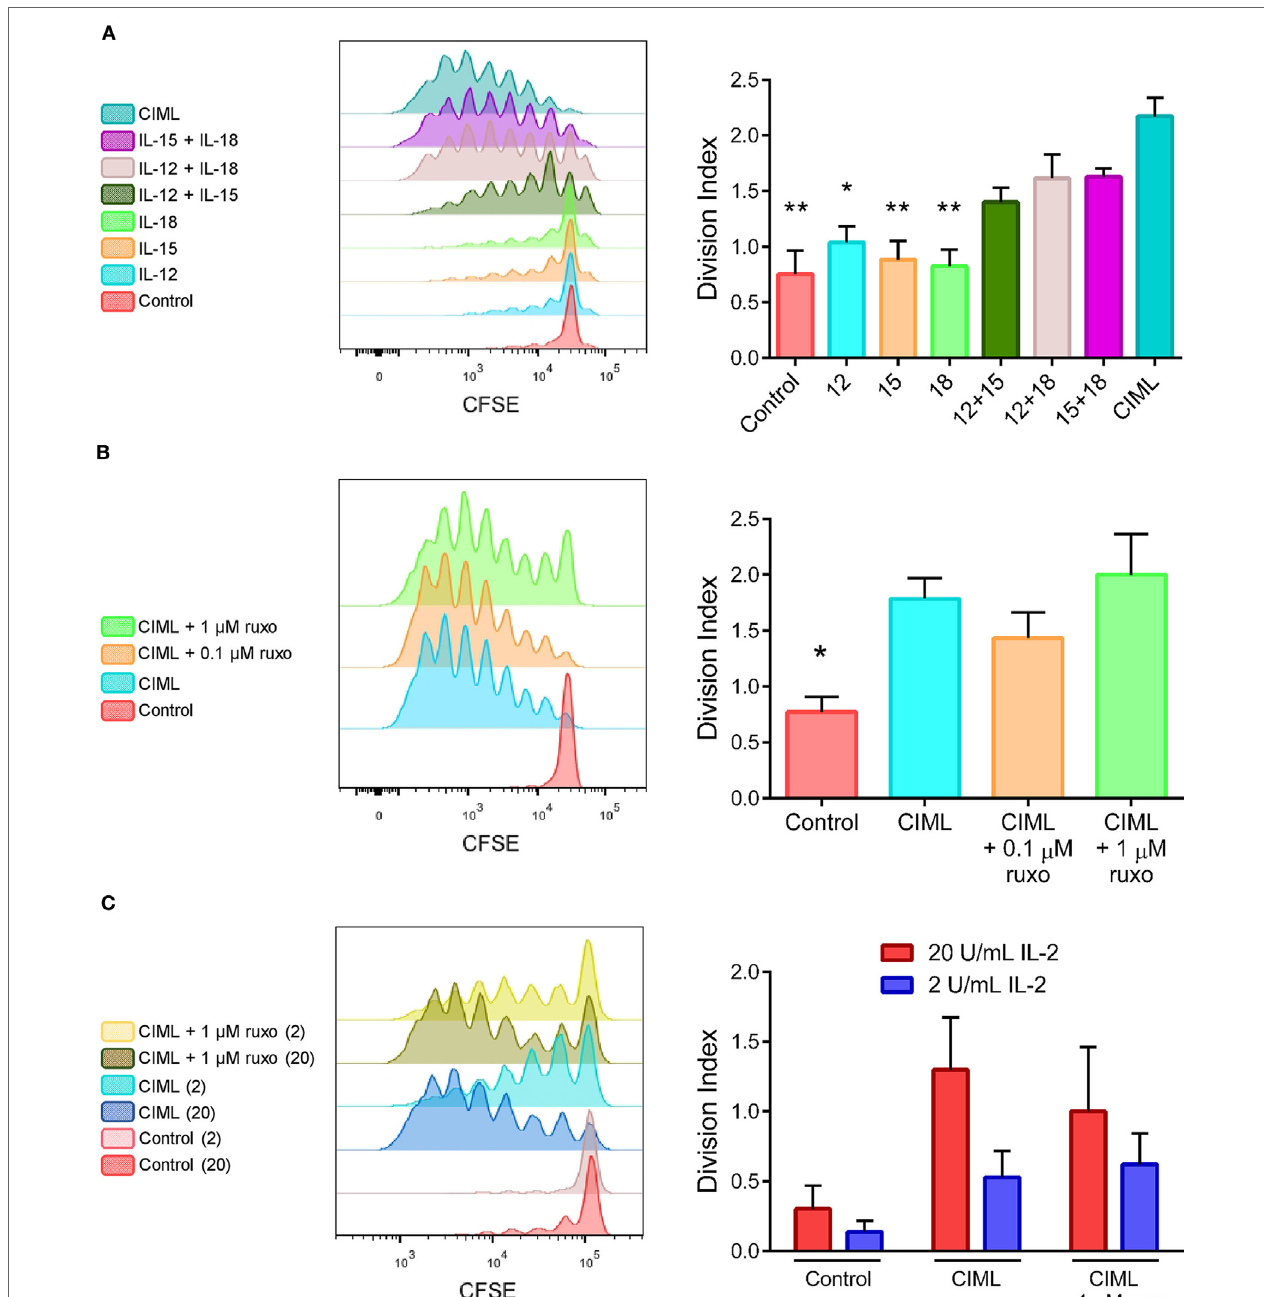
FigUre 5 | IL-2-induced proliferation of cytokine preactivated natural killer (NK) cells at the end of the expansion phase of 4 days. (a) Histograms of a representative experiment (left) and bar graphs showing the division index (DI) (right) of control non-preactivated and cytokine preactivated NK cells ( n = 6). (B) A representative experiment (left) and bar graphs showing the DI (right) of control non-preactivated and cytokine-induced memory-like (CIML) NK cells, and CIML NK cells preactivated in the presence 0.1 and 1 µM ruxolitinib ( n = 5). (c) A representative experiment (left) and bar graphs showing the DI (right) of control non-preactivated and CIML NK cells, preactivated in the presence and absence of 1 µM ruxolitinib, exposed to 2 or 20 U/mL IL-2 during the expansion phase ( n = 5). The bar graphs show the mean with SEM. Differences between CIML NK cells and the rest of conditions were established with Friedman test. * p < 0.05, ** p <